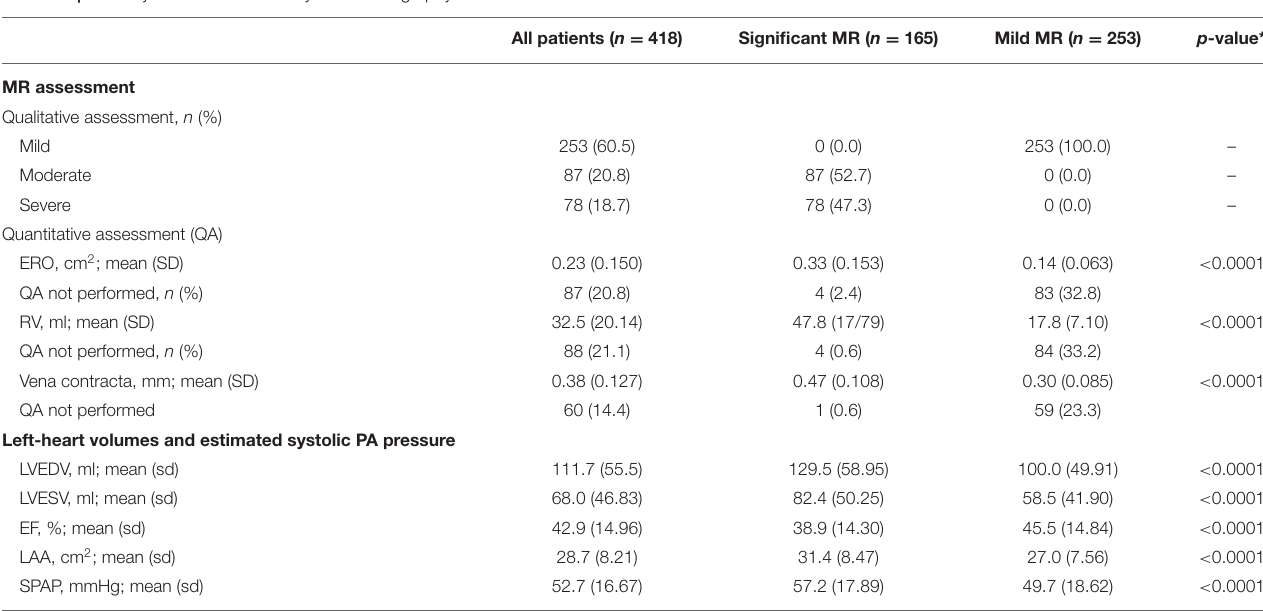
TABLE 3 | Hemodynamic assessment by